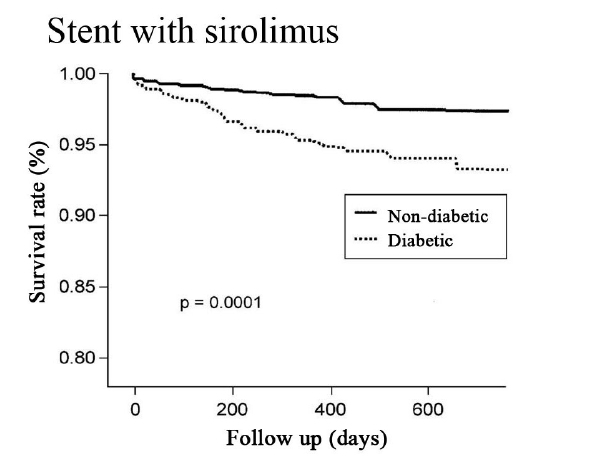
Fig. 1 – EVASTENT study [6]: late survival in diabetic and non- diabetic patients after stenting with